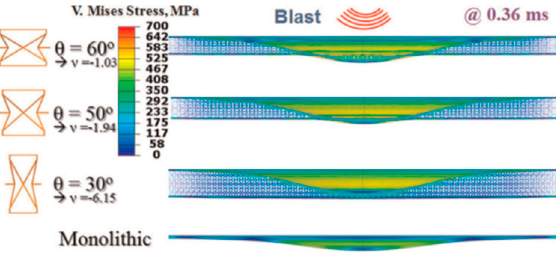
Figure 13. The blast absorbing structure of the negative Poisson’s ratio cell [68].